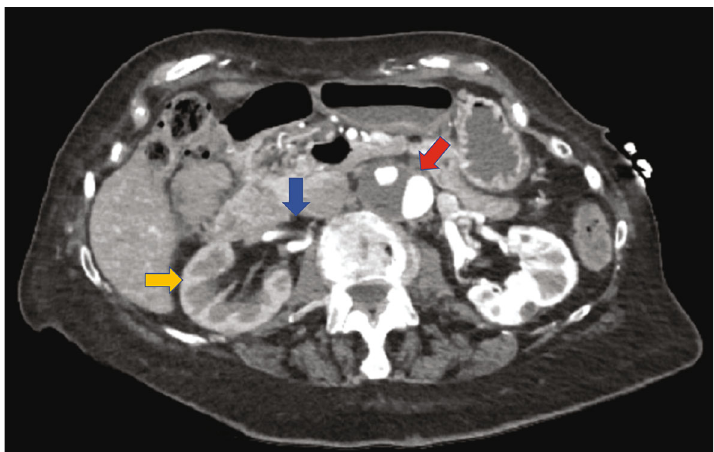
Figure 1: CTA of the aorta of the patient with bilateral run o ff showing infrarenal dominant abdominal aortic aneurysm with juxtarenal aortic dissection (red arrow); it also shows that the false lumen supplies the right renal artery which is mostly thrombosed (blue arrow), in addition to delayed right kidney nephrogram (yellow arrow).